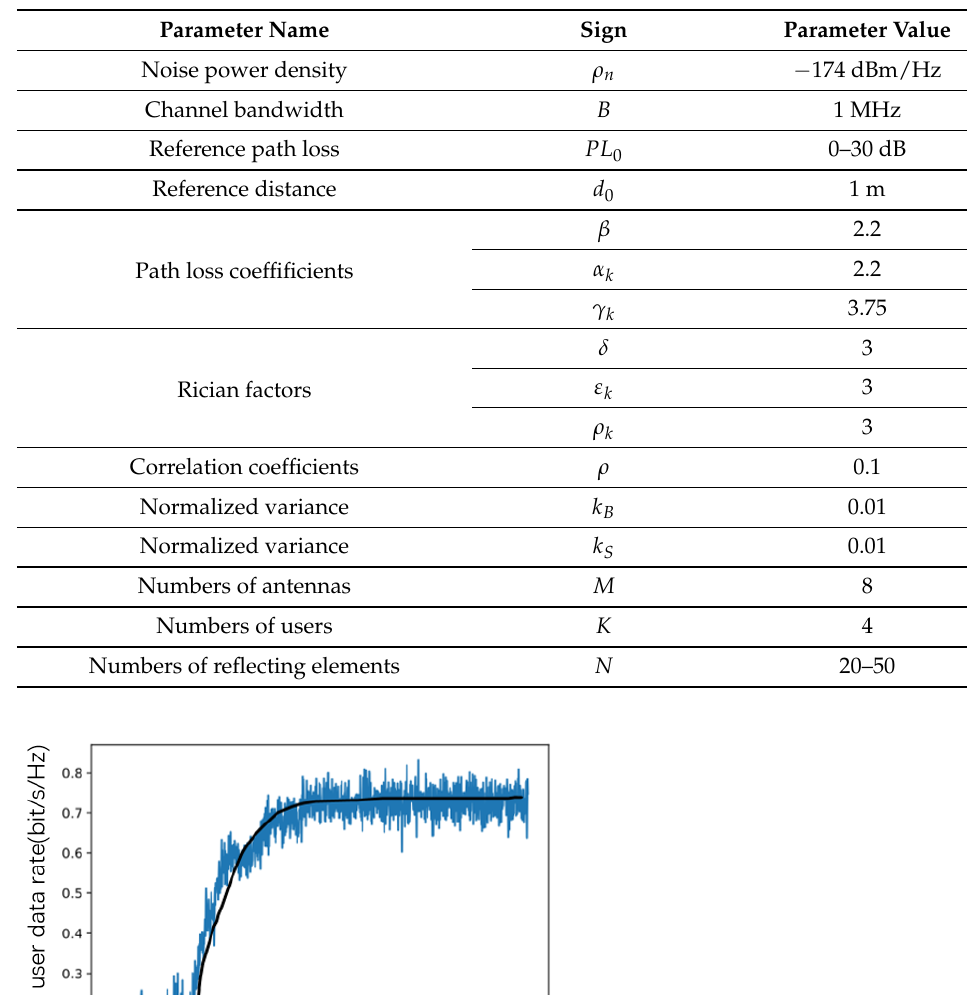
Table 2. Simulation Parameters.